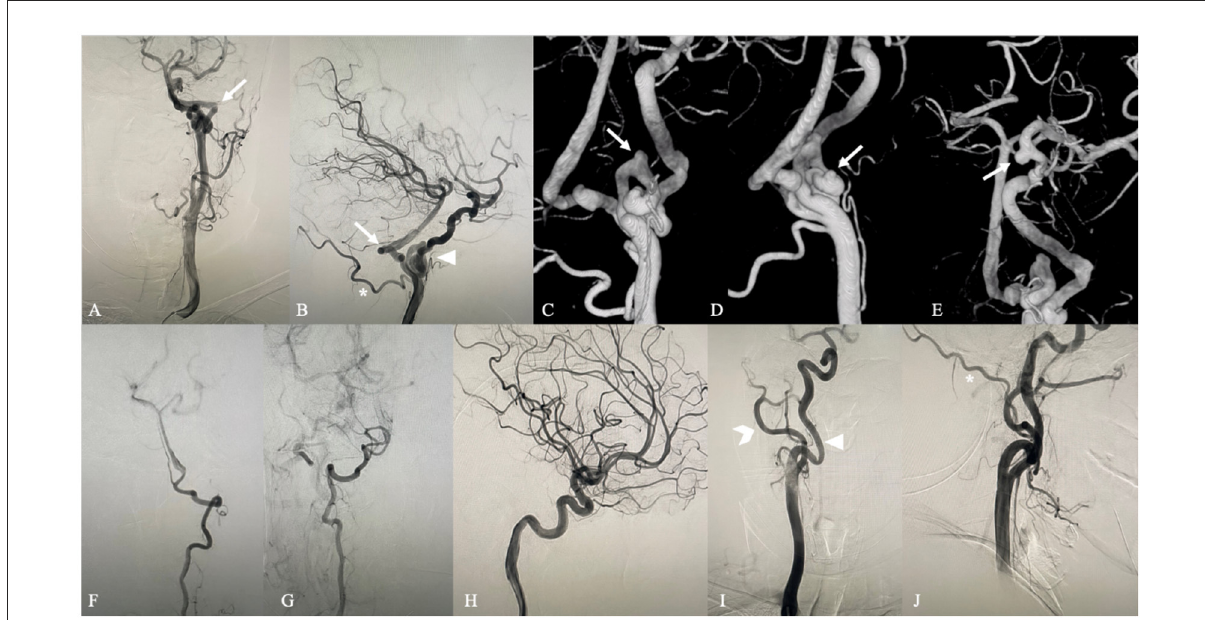
FIGURE2 Digital subtraction angiography. Anteroposterior (A) and lateral (B) left carotid artery angiograms show the PPTA (arrow) originating from the left cervical segment of the ICA and converging to the proximal part of the basilar artery. An extremely coiling segment of the ICA similar to a ball of string exists close to the beginning of PPHA distally (arrow head). The left occipital artery (asterisk) arises from the cervical segment of the ICA rather than the external carotid artery (forked tail) and is close to the beginning of PPHA proximally. 3D DSA shows two aneurysms at the coiling part of the ICA (C,D) (arrow) and an aneurysm at the posterior communicating artery segment of the ICA (E) (arrow). Anteroposterior left and right vertebral artery angiograms (F,G) demonstrate that bilateral vertebral arteries are hypoplastic with a small caliber. Posterior communicating arteries were not visualized bilaterally through left and right lateral carotid artery angiograms (B,H) . Anteroposterior (I) and lateral (J) right carotid artery angiograms show that the right extracranial ICA (arrowhead) is a normal tortuosity type and that the right occipital artery (asterisk) arises from the right ECA (forked